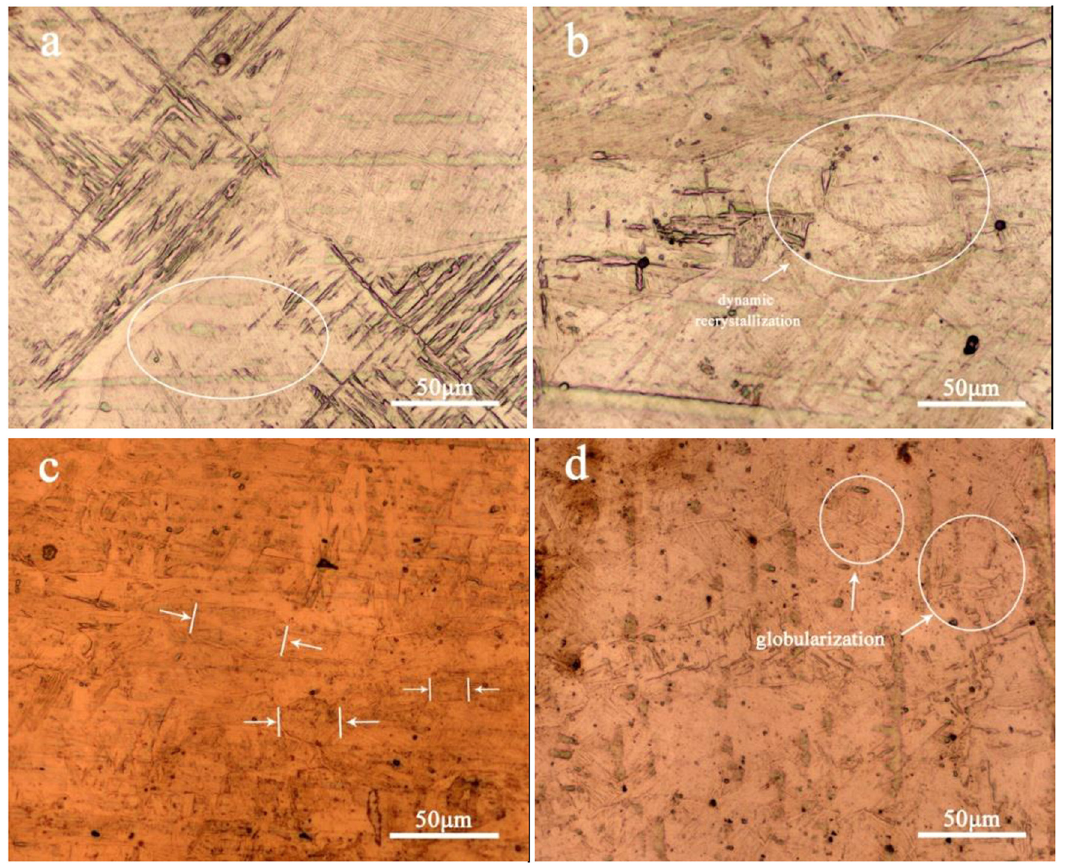
Figure 7: OM images of the samples at the deformation of two - pass: ( a ) 0.01 s − 1 , ( b ) 0.1 s − 1 , ( c ) 1 s − 1 and ( d ) 5 s − 1